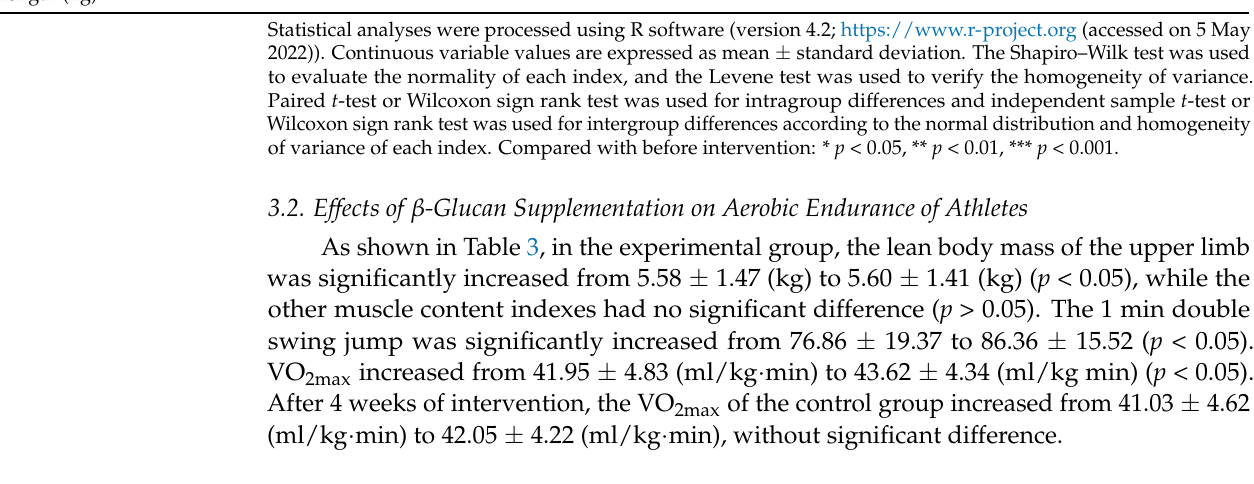
Table 3. Comparison of the index results of the whole-body muscle content before and after the intervention in the two groups of